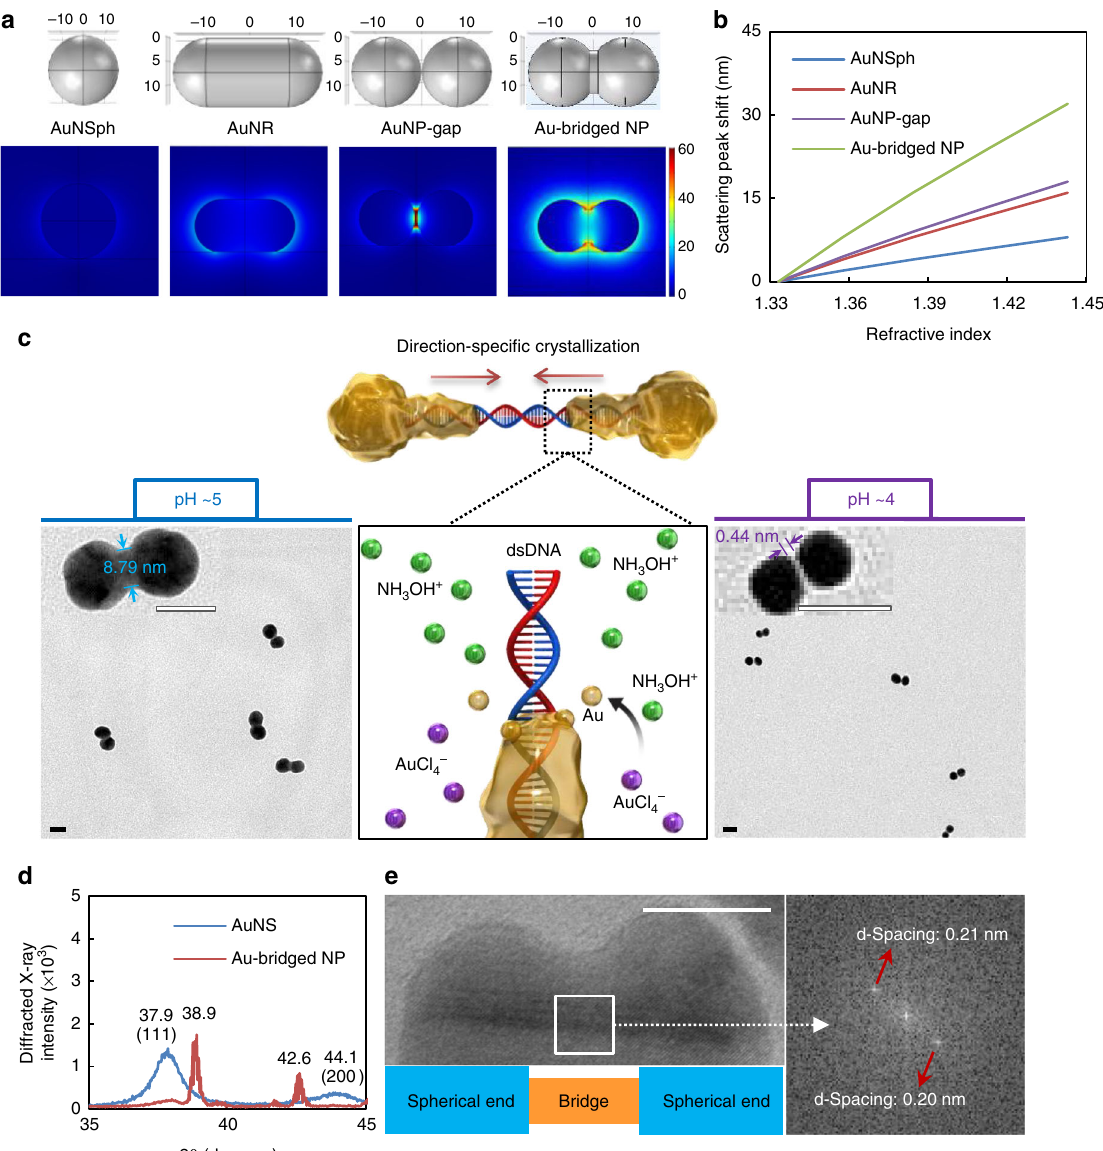
Fig. 1 Synthesis-by-design of plasmonic nanoparticles (NPs) in solution. a Illustrations of the designed NP models (upper; dimensional unit, nm) and plasmon resonance electric fi eld patterns (below; unit, V m − 1 ) generated by numerical simulations. b Linear fi ts to localized surface plasmon resonance (LSPR) wavelength shifts vs. changes in the refractive index (RI) of the NP surroundings. c Schematic diagram showing the early stage of direction-speci fi c, contour-following, and shape-controlled crystallization of Au atoms by reducing AuCl 4 − with NH 3 OH + . The water interface of DNA provides precise controllability under the synthetic conditions at pH 5 and 4, generating NPs with nanobridges and nanogaps respectively, as shown in the transmission electron microscopy (TEM) images. Scale bars, 20 nm. d X-ray diffraction spectra of AuNSs and Au-bridged NPs. e High-resolution transmission electron microscopy (HR-TEM) image of the DNA-directed nanocrystal and fast Fourier transform pattern (right) of the selected area. Scale bar, 10 nm. Source data of Fig. 1b and d are provided as a Source Data fi